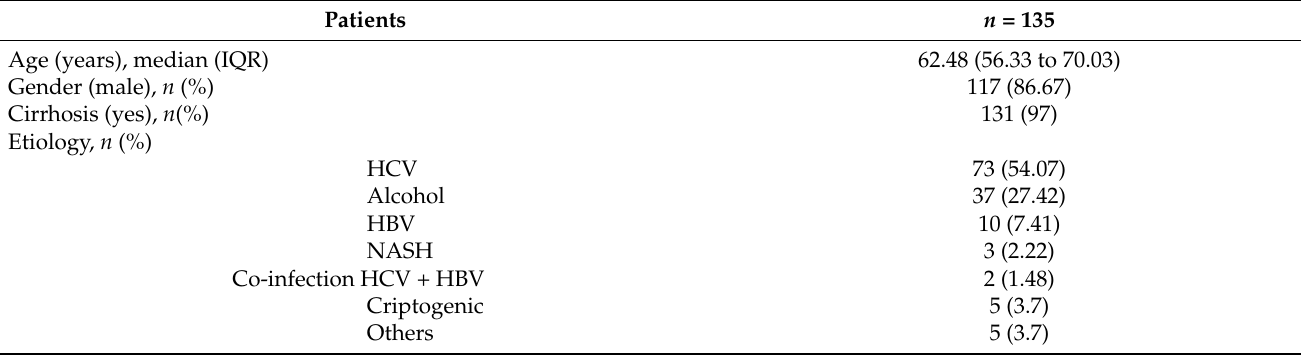
Table 1. Baseline characteristics and clinical variables of